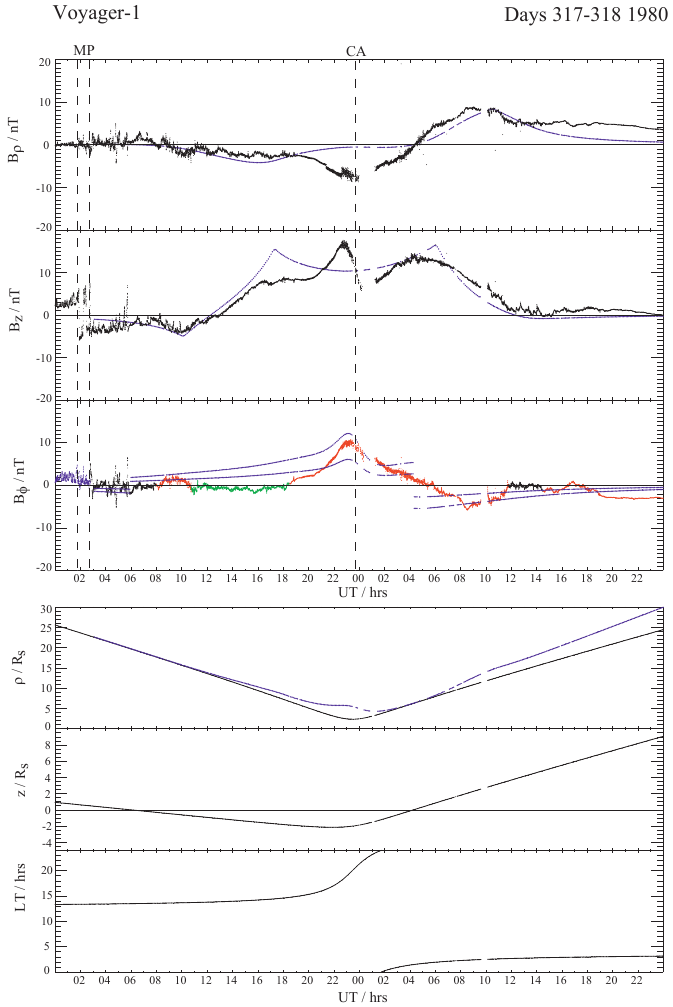
Fig. 5. Plot showing magnetic field and spacecraft position data for the Saturn flyby of Voyager-1. Two (Earth) days of data are shown, corresponding to days 317 and 318 of 1980. The top three panels show the residual field components in cylindrical co-ordinates referenced to the planet’s spin (and magnetic) axis, that is, from the top downwards, B ρ , B z , and B ϕ (innT). These residuals are the measured field minus the SPV model of the internal planetary field (which is zero in the case of the azimuthal component). The azimuthal field data are colour- coded according to the implied sense of the field line bending. The data are colour-coded red when the field (ignoring rapid fluctuations) is consistent with a ‘lagging’ configuration, green when it is ‘leading’, and black when the field is on average close to zero. The data are colour-coded blue for magnetosheath/magnetopause intervals. The blue dotted lines in the top two panels show the components of the ring current field model derived by Connerney et al. (1983) (which again has zero azimuthal component). The model parameters are R 1 = 8 R S , R 2 = 15 . 5 R S , D = 3 R S , and µ o I o ≈ 60 . 4nT. The dotted lines in the panel showing the azimuthal magnetic field are calculated for the plasma sub-corotation effect using Eqs. (1)–(5), with 6 ∗ equal to 1mho (inner line) and 2mho (outer line). The three lower panels give the P position of the spacecraft in cylindrical co-ordinates, showing the cylindrical radial distance from the planet’s spin (and magnetic) axis ρ , the distance along this axis from the equatorial plane z , and the local time (hours). The blue dotted line in the upper of these position panels shows the radial distance at which the field line passing through the spacecraft crosses the equatorial plane, determined from the SPV plus Connerney et al. (1983) ring current model employed here. The left-hand vertical dashed lines marked ‘MP’ show the positions of the first and last of five inbound magnetopause transitions, which occurred at spherical radial distances between 23 and 24 R S . The central vertical dashed line marked ‘CA’ shows the closest approach of the spacecraft to the planet, at a spherical radial distance of 3.1 R S .